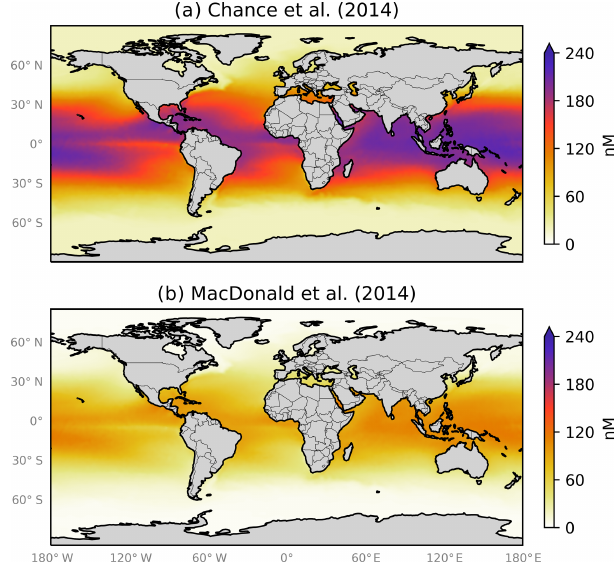
Figure 1. Annual average sea-surface iodide concentrations pre- dicted by (a) Eq. (1) from Chance et al. (2014) and (b) Eq. (2) from MacDonald et al. (2014). Temperature fields used to make spa- tial predictions were from the World Ocean Atlas (Locarnini et al., 2013). Earth raster and vector map data used are freely available from Natural Earth (http://www.naturalearthdata.com/, last access: 23 July 2019).